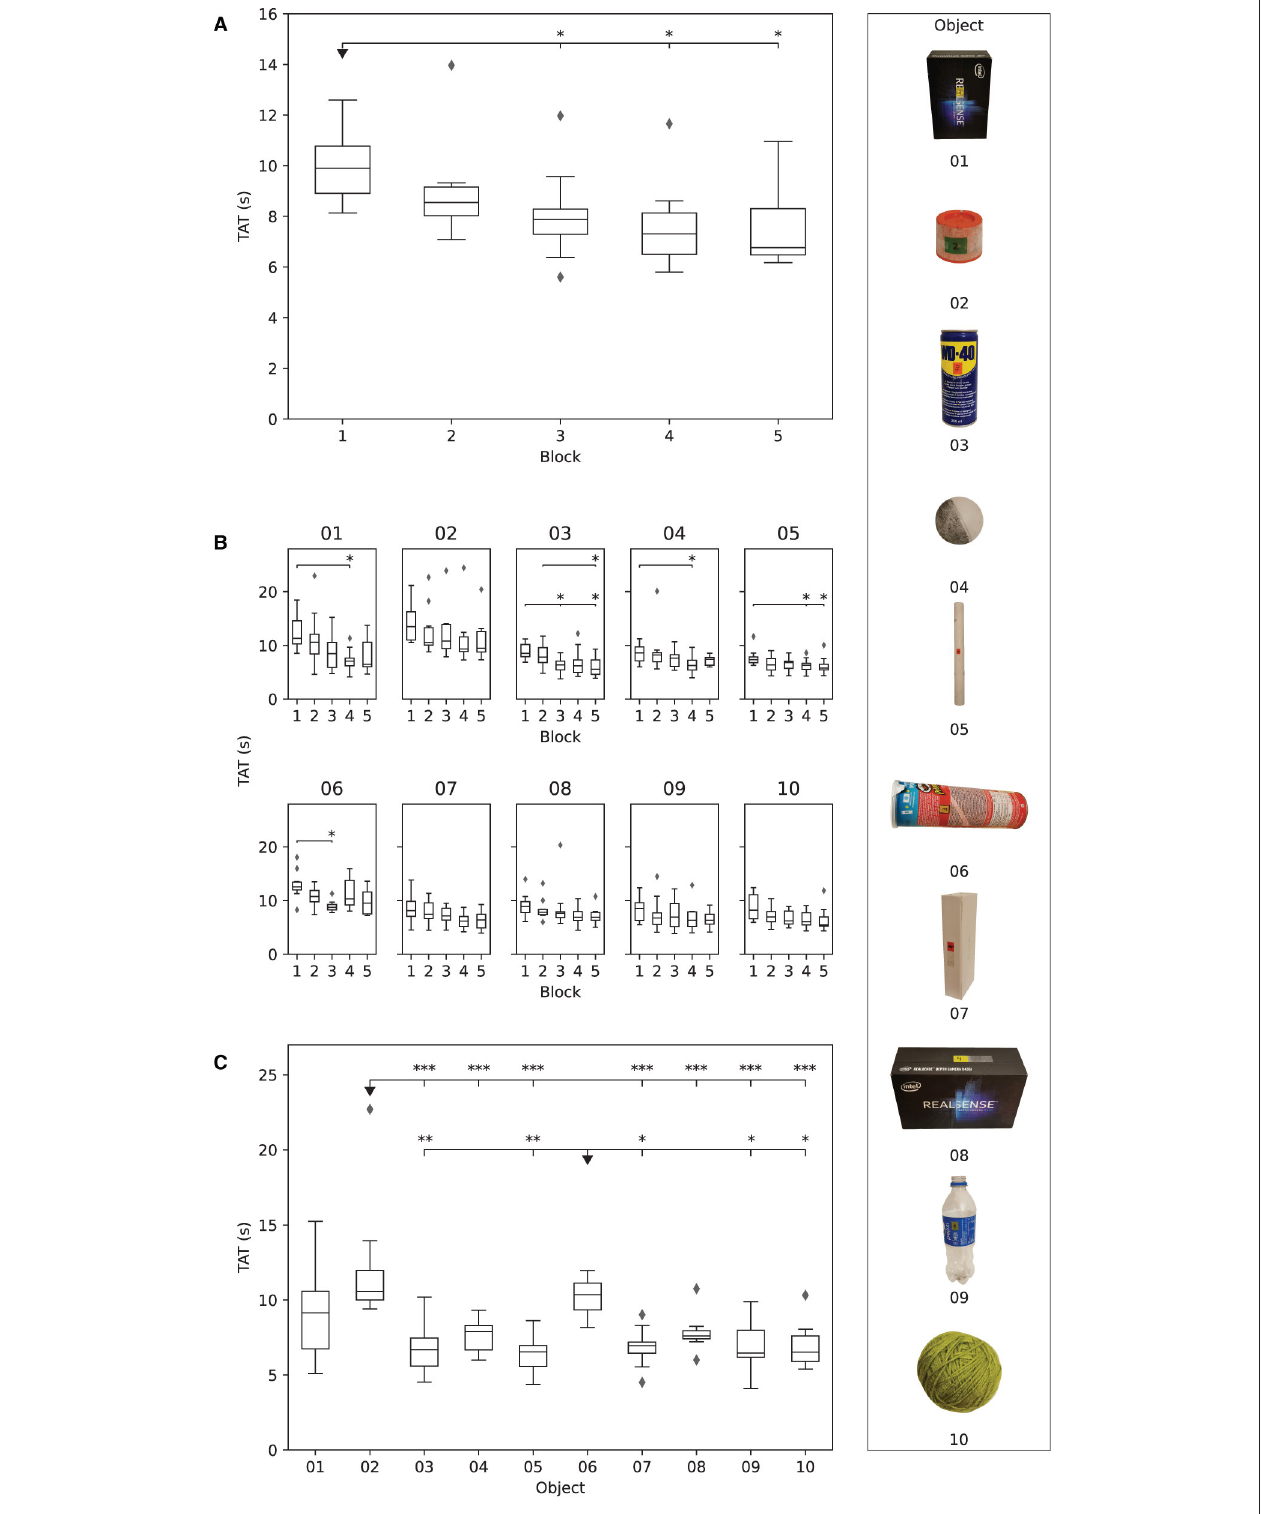
FIGURE 8 | The results obtained in Phase I. The boxplots show: (A) median time to accomplish the task (TAT) for each subject in each block, (B) median TAT of all subjects for each object in each block, and (C) median TAT per object across all blocks. The stars indicate statistical significance (* p < 0.5; ** p < 0.01; *** p < 0.001).